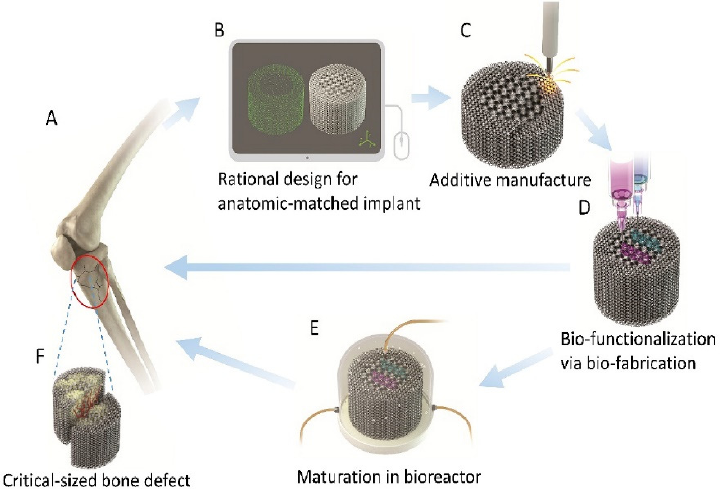
Figure 10. Schematic of an iterative optimization process for hybrid additively manufacture (AM) patient-specific Ti implant fabrication including ( A ) critical-size bone defect data collection by CT scanning followed by ( B ) modeling through rational design, which is ( C ) additive manufactured with precisely controlled architectures. After necessary surface modification, implants can be ( D ) bio-functionalized through cell/growth factor incorporation with the assistance of bio-fabrication strategies and subsequent transplantation to repair the defect or ( E ) incubated for in vitro maturation in a bioreactor and then transplanted, leading to ( F ) rapid bone and vasculature formation. Reprinted with permission from ref. [54]. 2020, Elsevier Ltd. Table 5. Multifunctional Porous Implants .